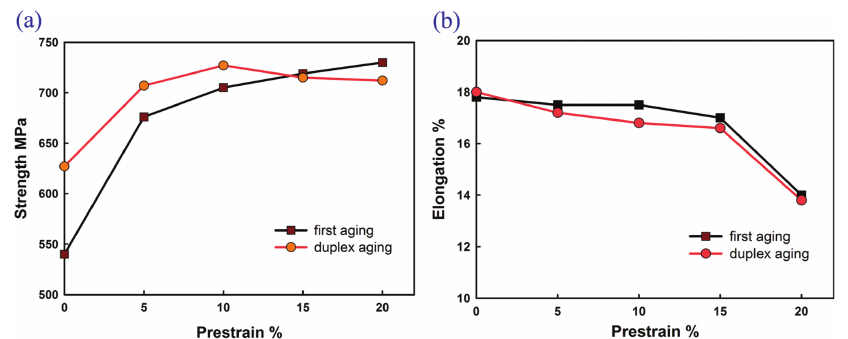
Figure 4: Comparison of (a) yield strength and (b) elongation for first and duplex